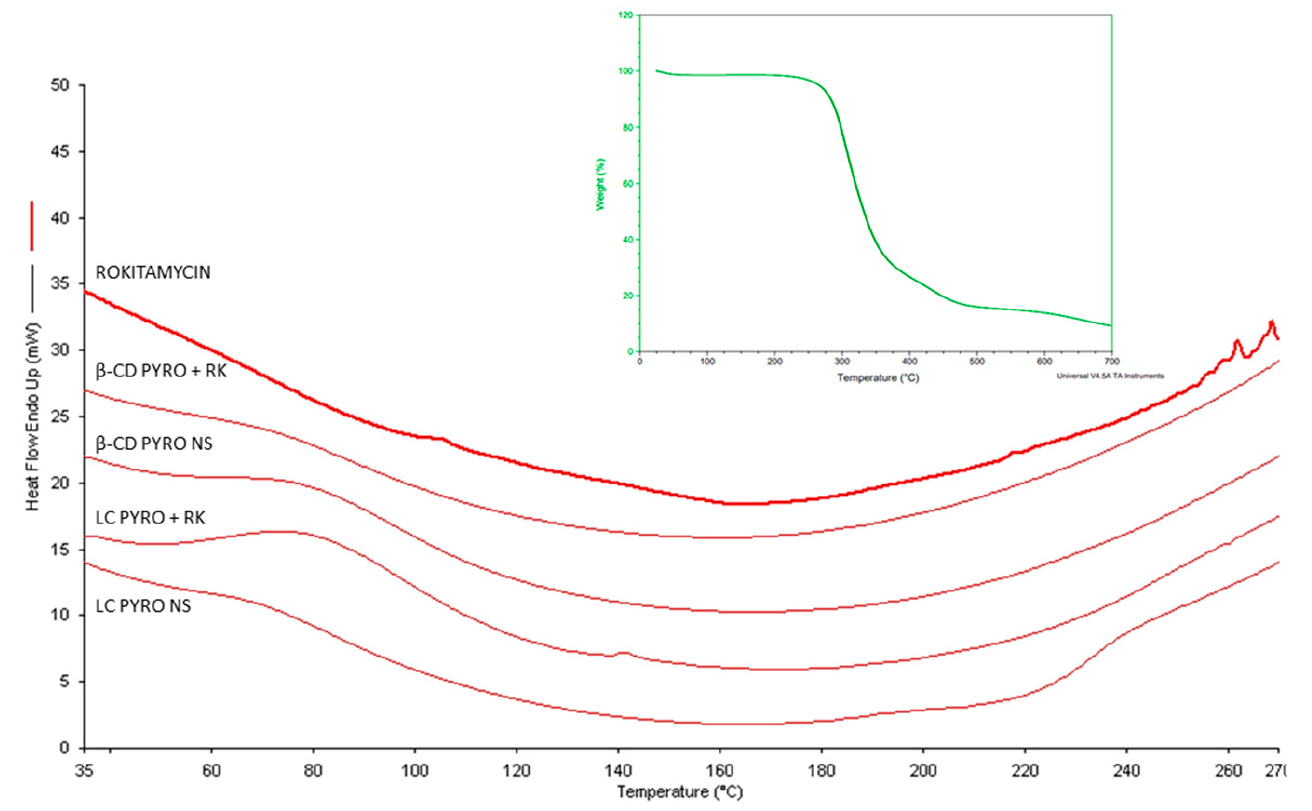
Figure 6. DSCthermogramsRK,blankNSs, andRK-loadedNSs. Insert.